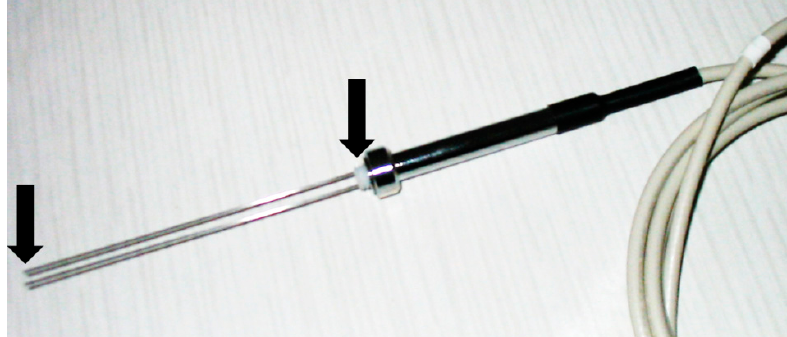
Figure 1. LP/ms probe (ETest, Lublin, Poland) for moisture determination using TDR method.